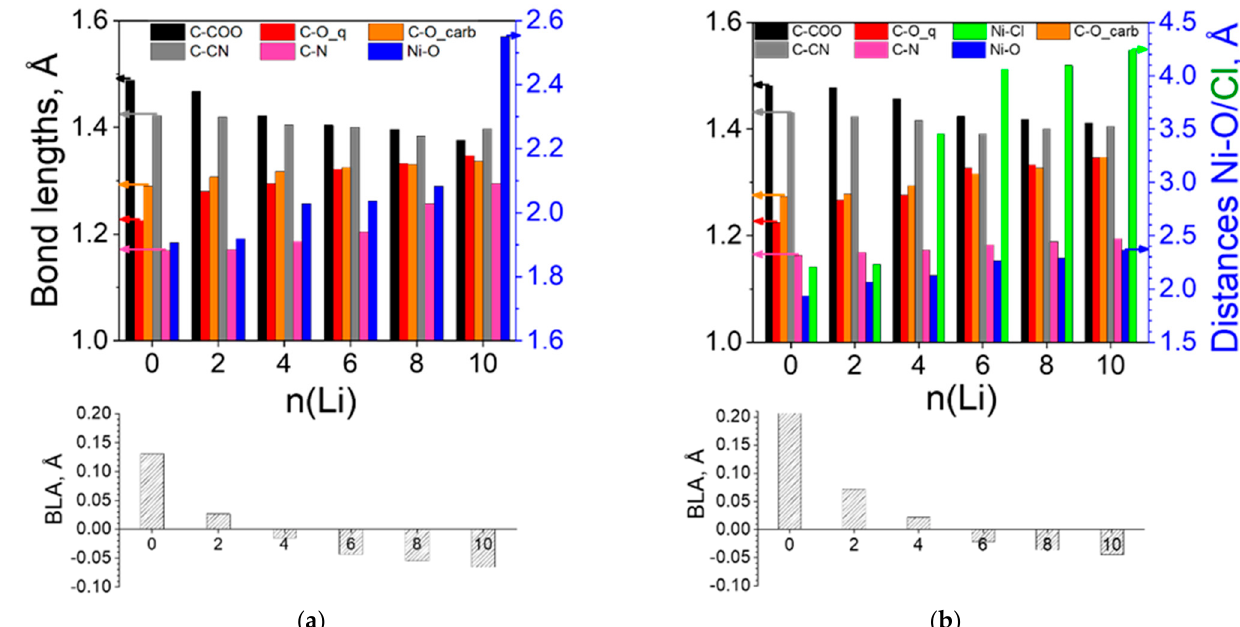
Figure 12. Variation in the averaged bond lengths and BLA of ( a ) [Ni(II)L3] n and ( b ) [Ni(IV)L3] n . Arrows instruct which axis corresponds to the values of the structural parameters. Numerical quantities can be found in Tables S10 and S11.